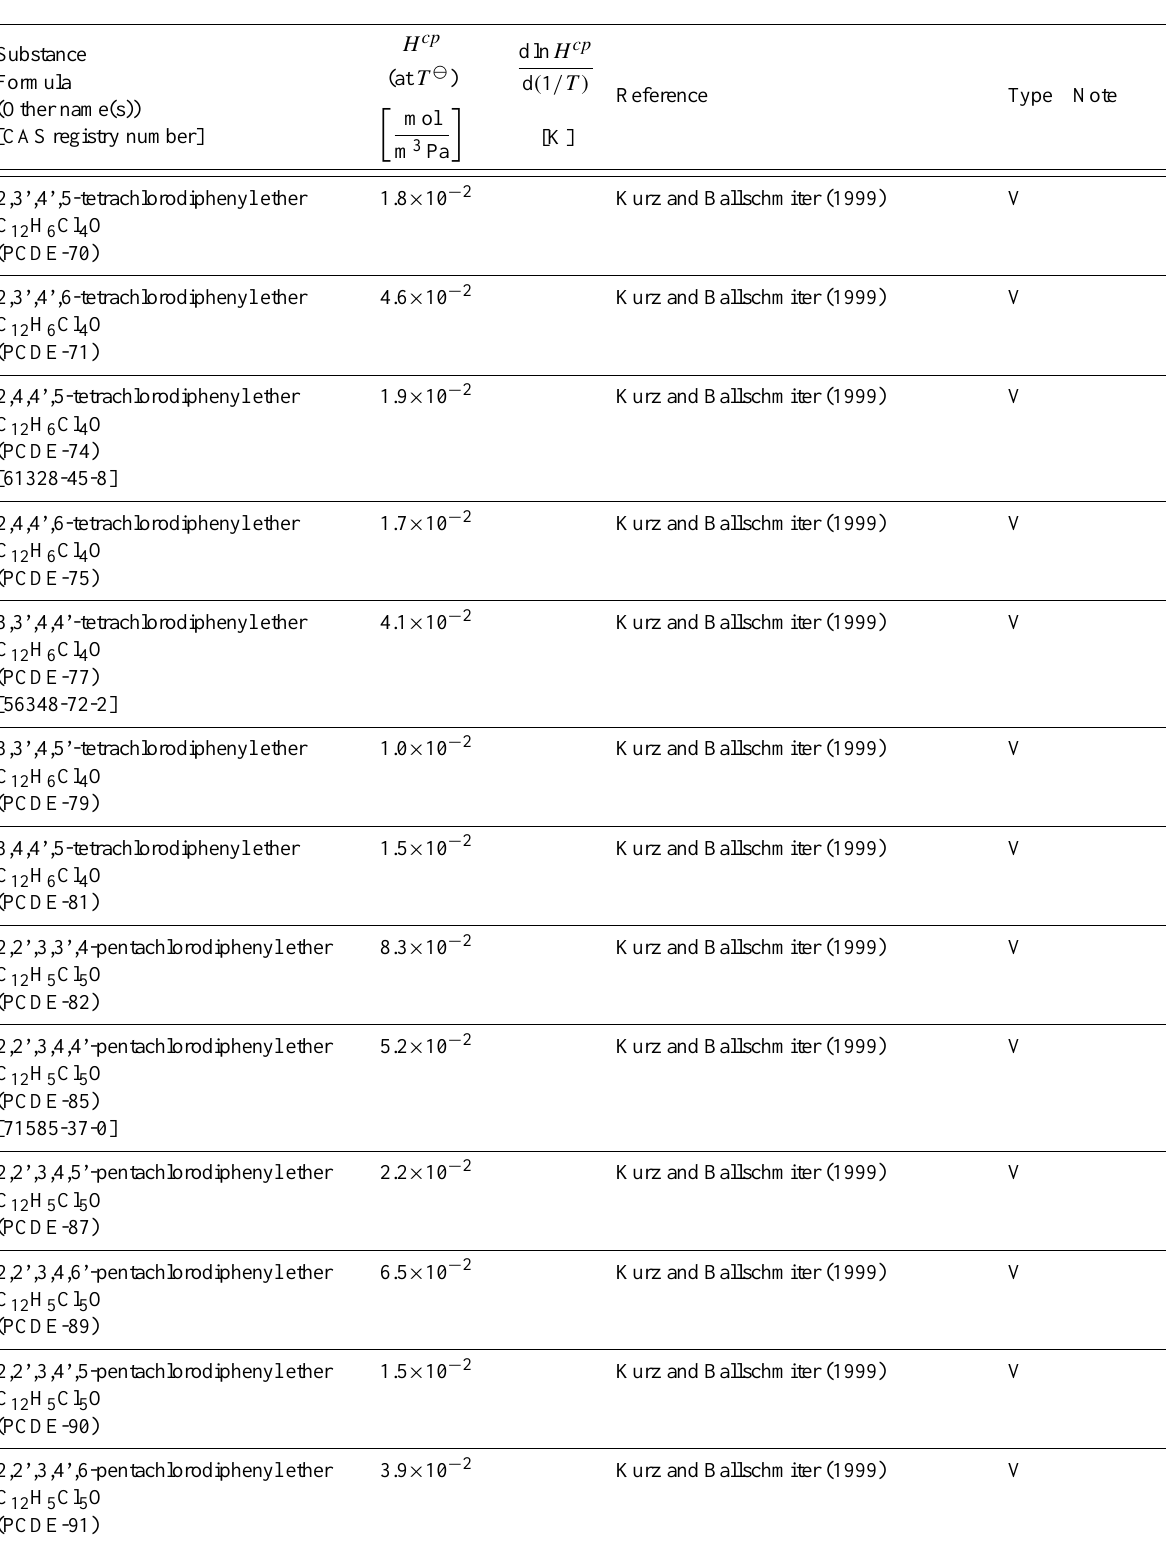
Table 6: Henry’s law constants for water as solvent